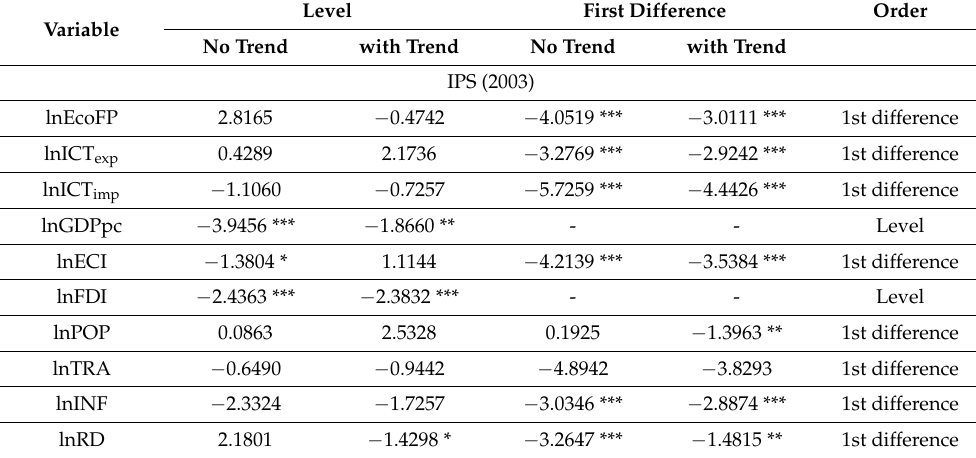
Table 4. Panel unit root